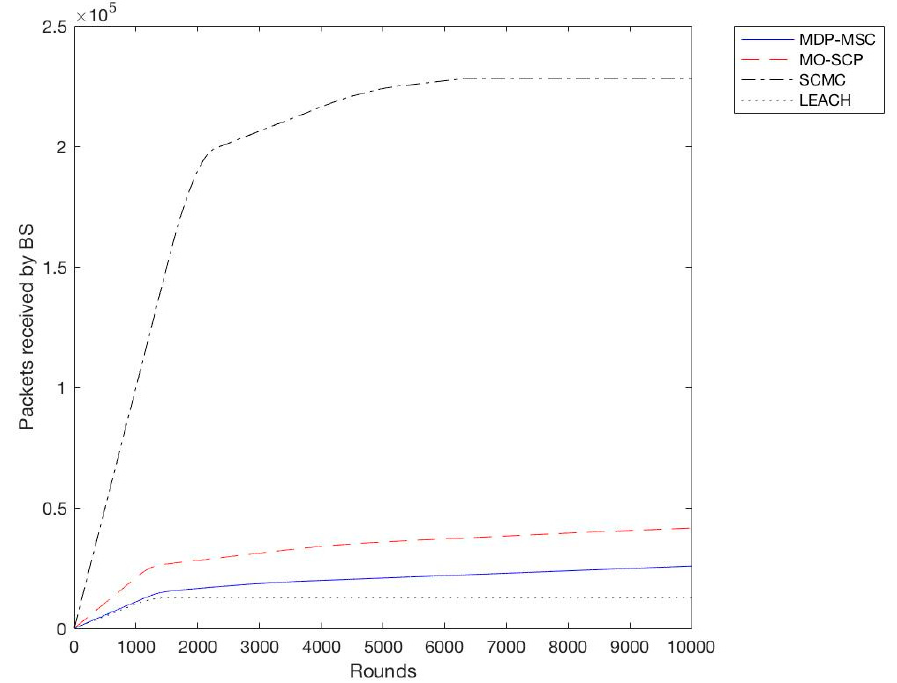
Figure 6. Throughput comparison of Set Cover Min-Cost max-flow (SCMC), Multi-Objective Set Cover Problem (MO-SCP), Minimum Distance Path-Maximum Set Cover (MDP-MSC), and Low-Energy Adaptive Clustering Hierarchy (LEACH). (Size = 100).